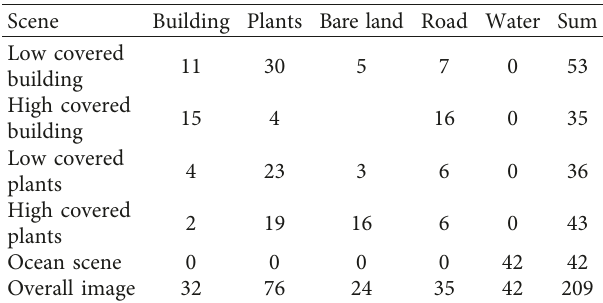
Table 3: Test sample statistics of image A.